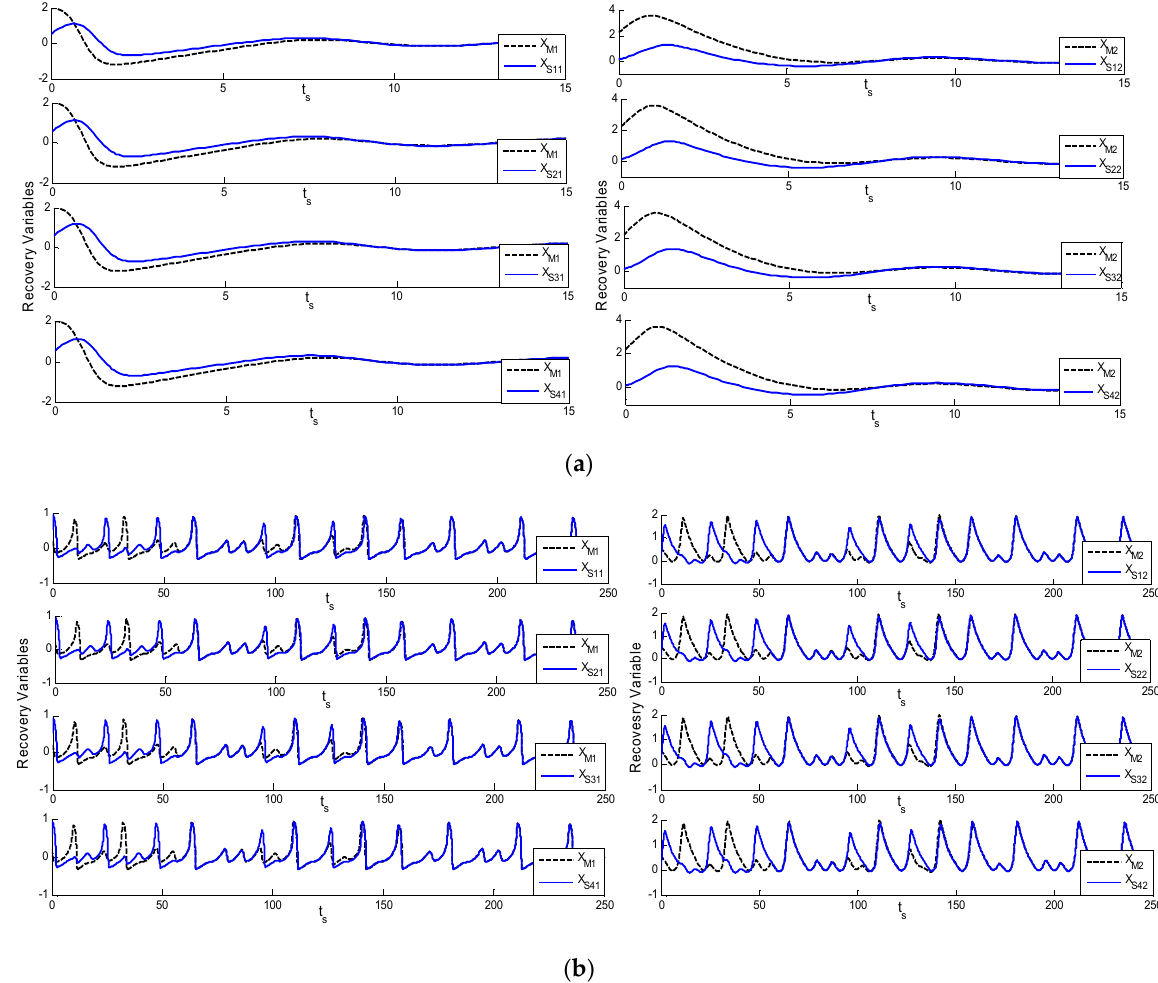
Figure 4. ( a ) Master and four slave systems and their respective observers; ( b ) observer recovery variables of Theorems 1